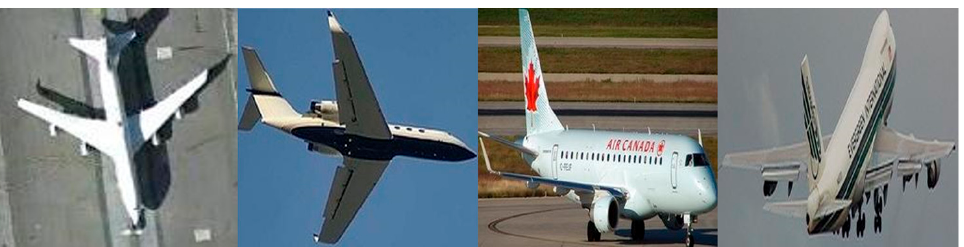
Figure 5. Data expansion in one target. The amount of original and augmentation data is shown in Table 1 where org ‐ set is the number of images integrated from the original different optical data sets, and aug ‐ mentation dataset is the number of enhanced data. Table 1. Amount of original and augmentation data by target type. Segment No.